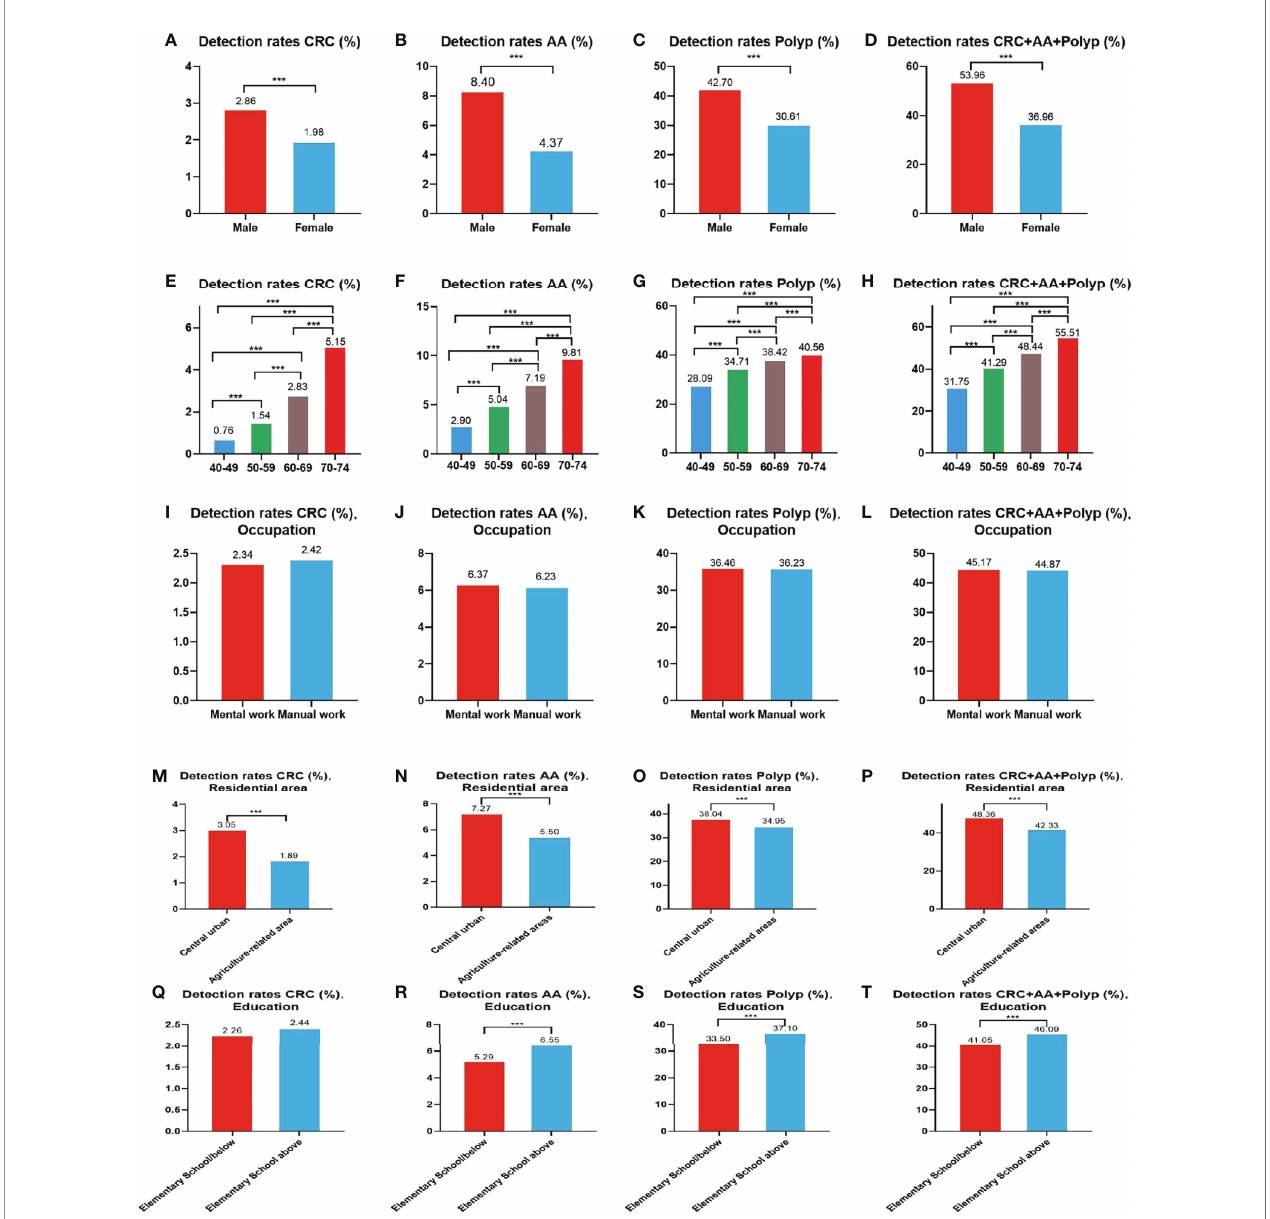
FIGURE 8 | Evaluation of the diagnostic performance of colonoscopy for CRC (A, E, I, M, Q) , AA (B, F, J, N, R) , CRC+AA+polyp (C, G, K, O, S) and polyps (D, H, L, P, T) . ***There are signi fi cant differences in detection rates between the different screening